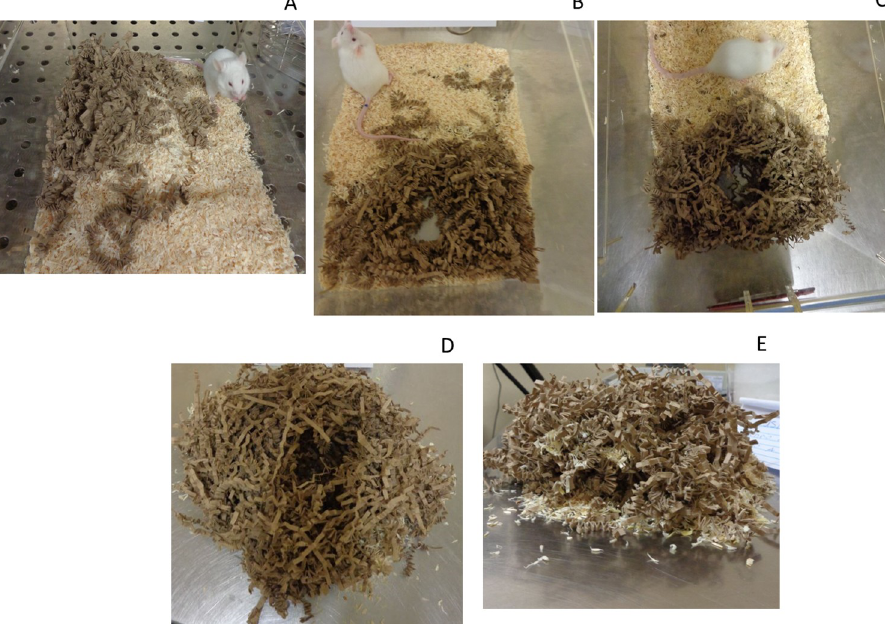
Fig 2. Nesting. Example of nest building. Nest score from 1 (A) to 2, 3, 4 and 5 (B to-E, see text for detailed description). There was no difference in nest score between the groups, either before stress, or after stress